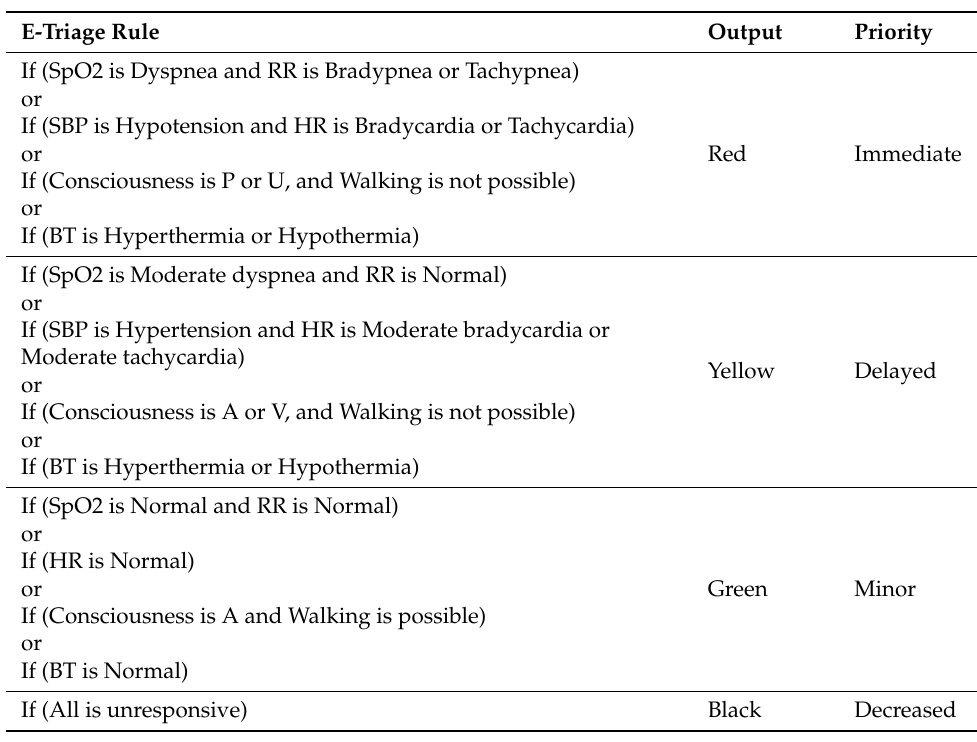
Table 3. The outputs of the e-triage tag